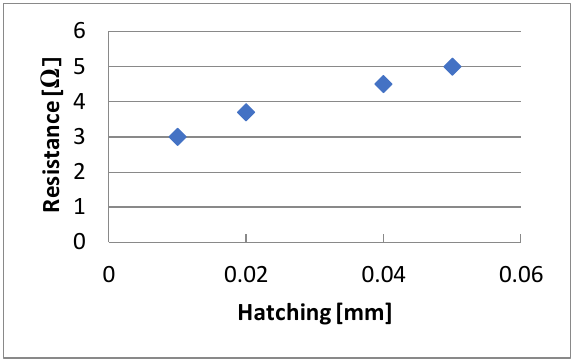
Figure 12. The dependence of resistance changes on hatching.